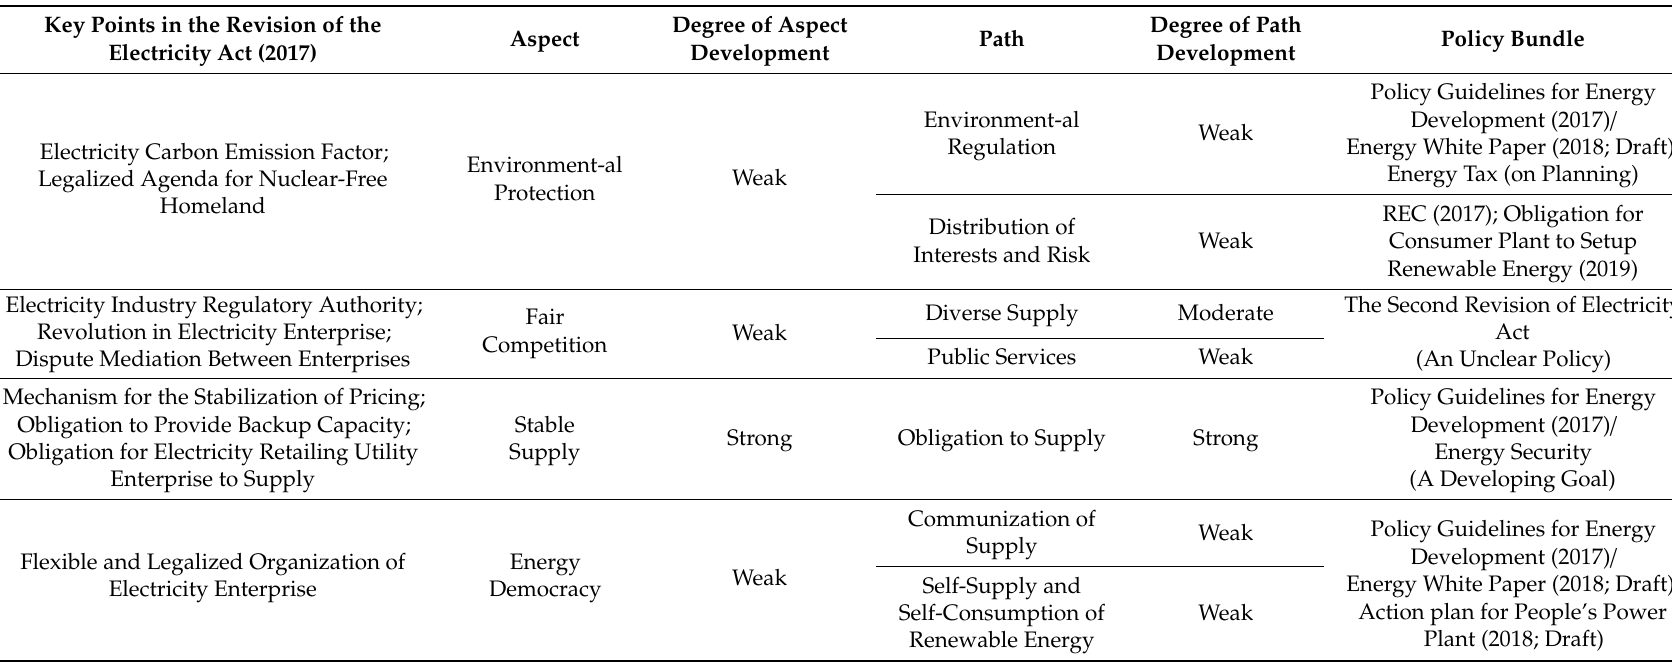
Table 2. Taiwan’s energy transition framework and its inter-connected policy bundles in new era of the Electricity